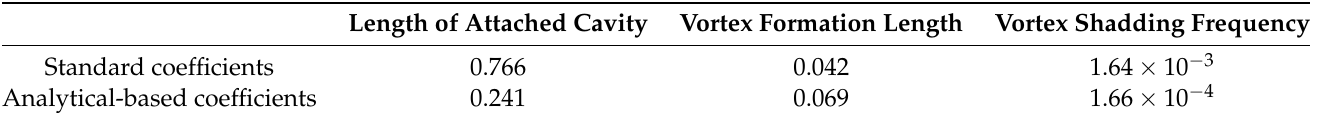
Table 10. Variances for the results of length of attached cavity, vortex formation length and vortex shedding frequency for standard and analytical-based